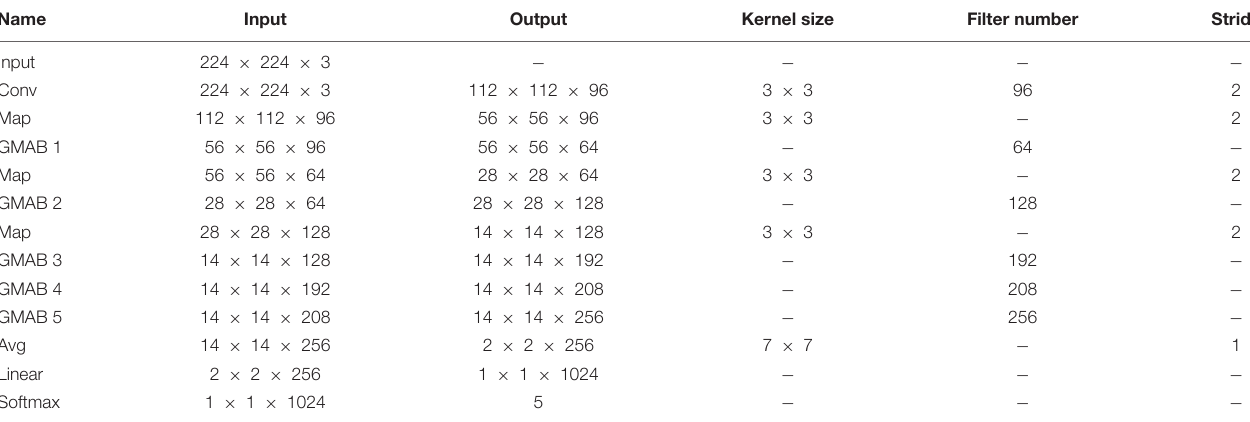
FIGURE 2 | The architecture of the proposed group multi-scale attention network (GMA-Net). TABLE 3 | Detailed architectures of the proposed GMA-Net model in our